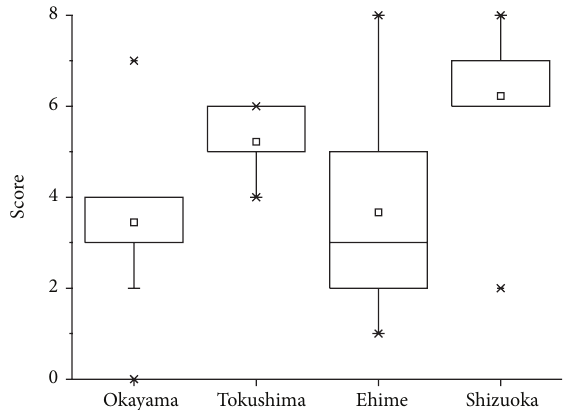
Figure 1: Overall scores of the sensory evaluation of green algae samples.